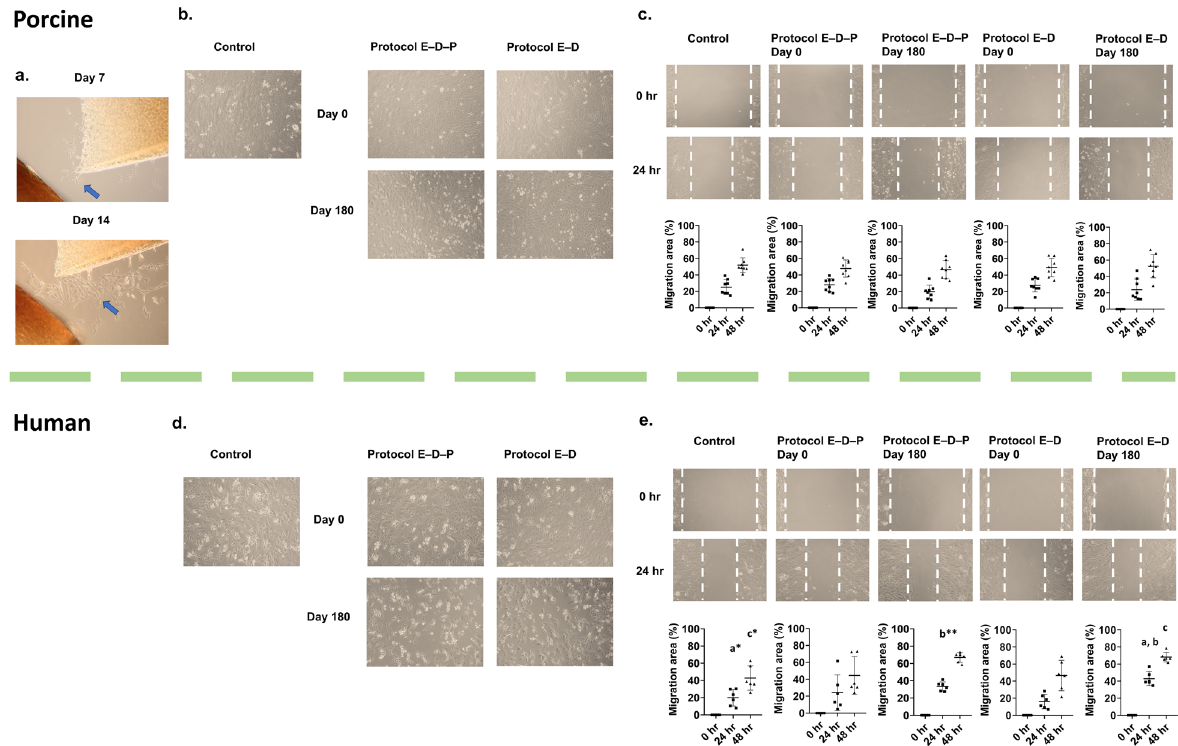
Fig. 4 Assessment of cell migrating ability of chondrocytes isolated from articular cartilage after vitri fi cation and subsequent rewarming. a Active viable porcine chondrocytes from particulated articular cartilage migrated from the cartilage matrix and proliferated in in vitro culture at day 7 and day 14. b Isolated porcine chondrocytes from post-vitri fi ed articular cartilage dedifferentiated into fi broblast-like cells and migrated to the center of the culture plates (×100 magni fi cation). c Isolated porcine chondrocytes from fresh control and vitri fi ed particulated articular cartilage migrated at similar speeds to heal the scratch wound when cultured in vitro ( n = 8 replicates per group: p = 0.811, two-way ANOVA). d Isolated human chondrocytes from postvitri fi ed articular cartilage dedifferentiated into fi broblast-like cells and migrated to the center of the culture plates (×100 magni fi cation). e When samples were stored for 6 months, isolated human chondrocytes from particulated articular cartilage using Protocol E – D migrated to heal the scratch wound with a faster migrating speed than the positive control, and the Protocol E – D group showed a faster migration than the Protocol E – D – P group at 24 h when cultured in vitro ( n = 6 replicates per group, p a = 0.016, p b = 0.004, p c = 0.043, two-way ANOVA with Tukey ’ s test). Error bars = SD. All data are represented as mean ± SD. For statistical differences, * p < 0.05, ** p <